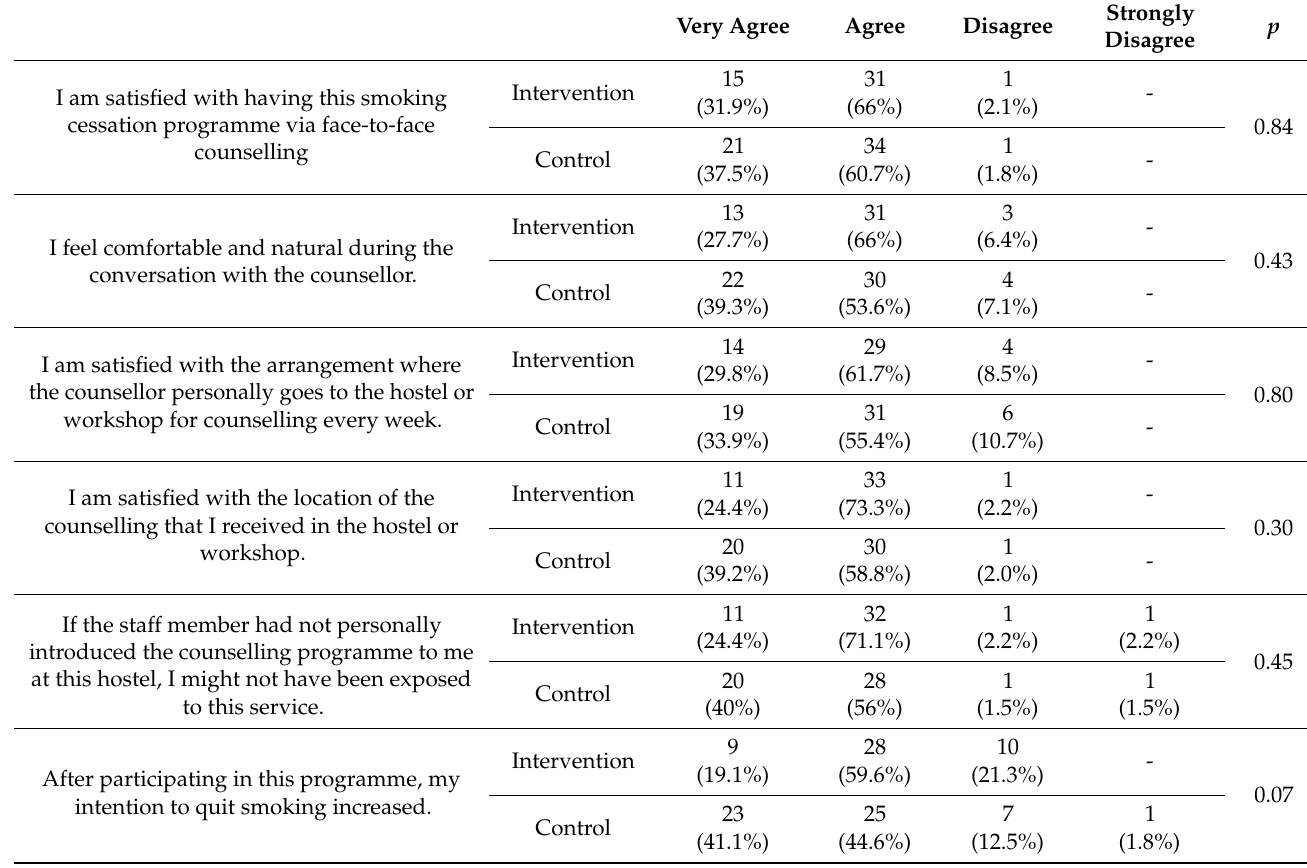
Table 4. Levels of satisfaction with the